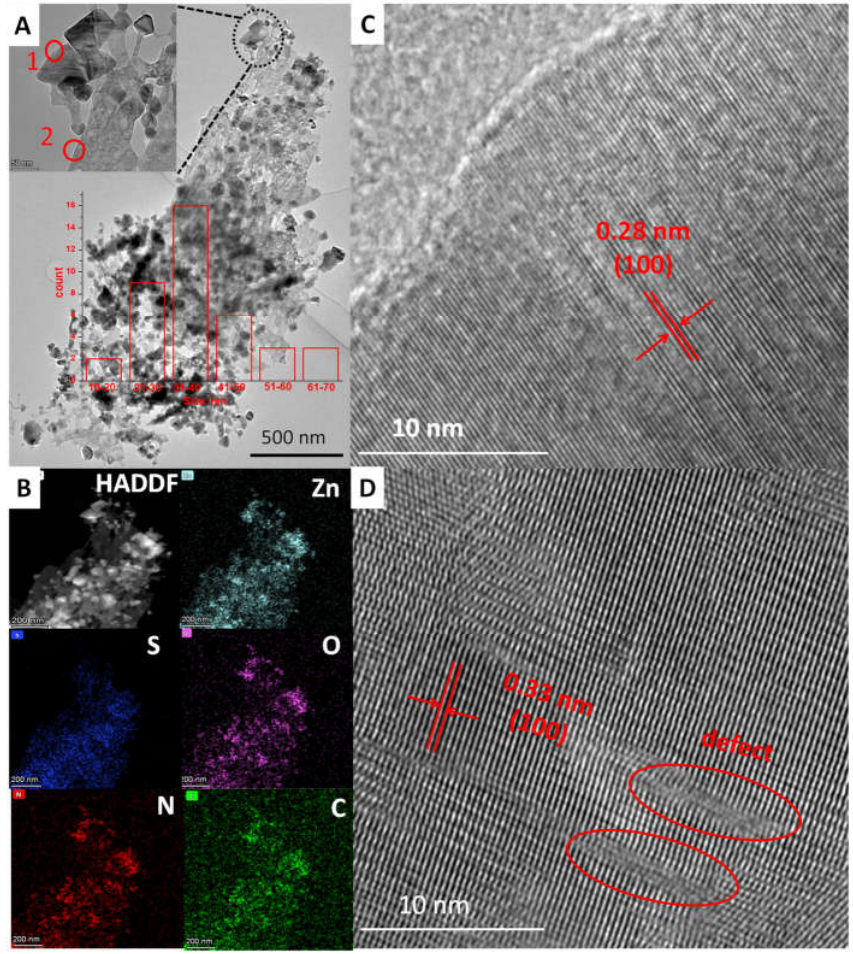
Figure 4. ( A ) TEM, ( B ) HAADF-STEM and Mapping images of ZnS/ZnO-0.5 h, ( C , D ) HRTEM images in site 1 and site 2 in A, respectively. Inset in A is the amount of the nanoparticles in different sizes.